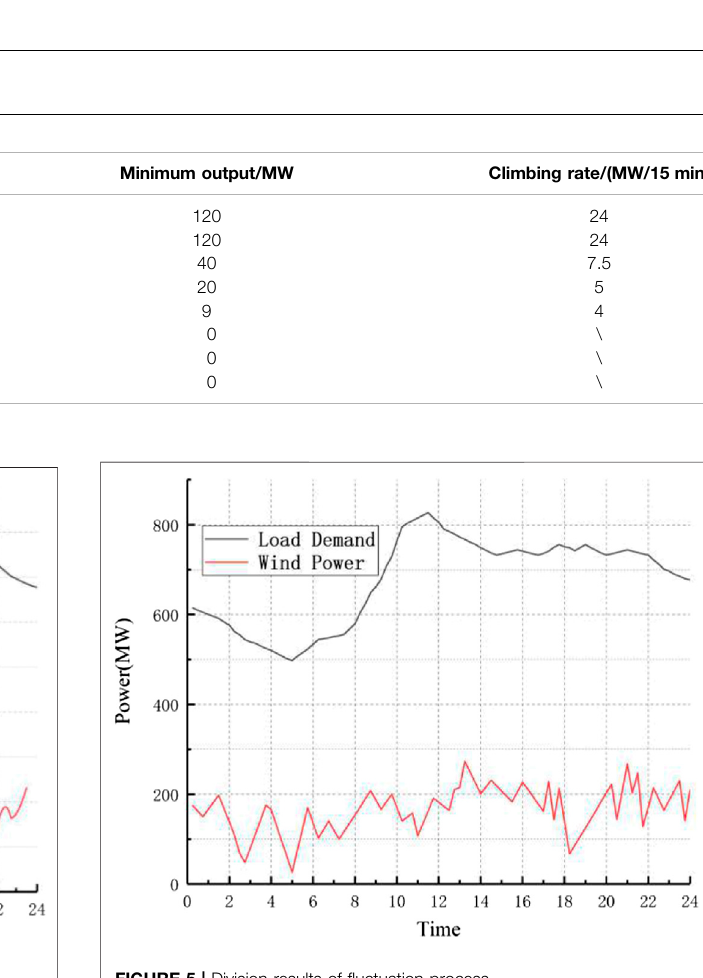
FIGURE 4 | Load curve and wind power output curve. FIGURE 5 | Division results of